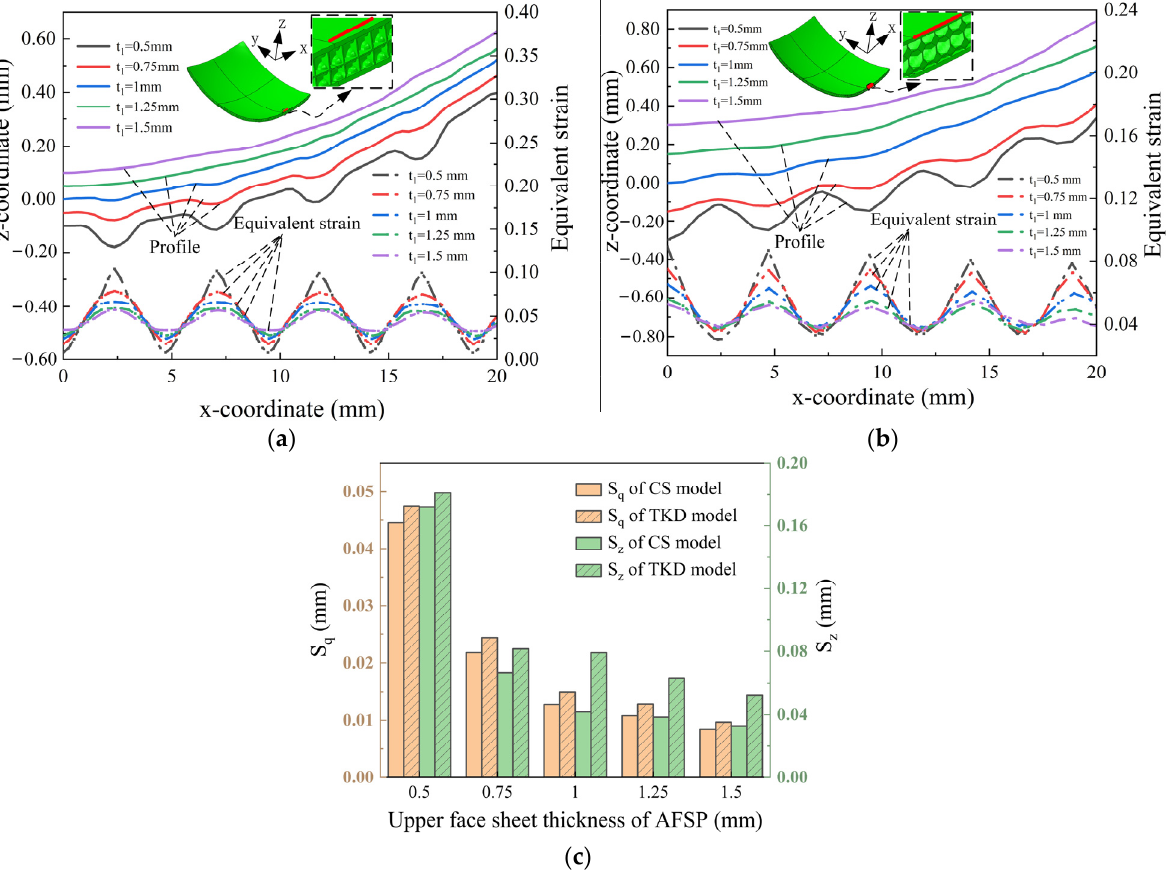
Figure 12. ( a ) CS model AFSP profile lines and equivalent strain with different upper face sheet thickness ( b ) TKD model AFSP profile lines and equivalent strain with different upper face sheet thickness ( c ) S q and S z of AFSP with different upper face sheet